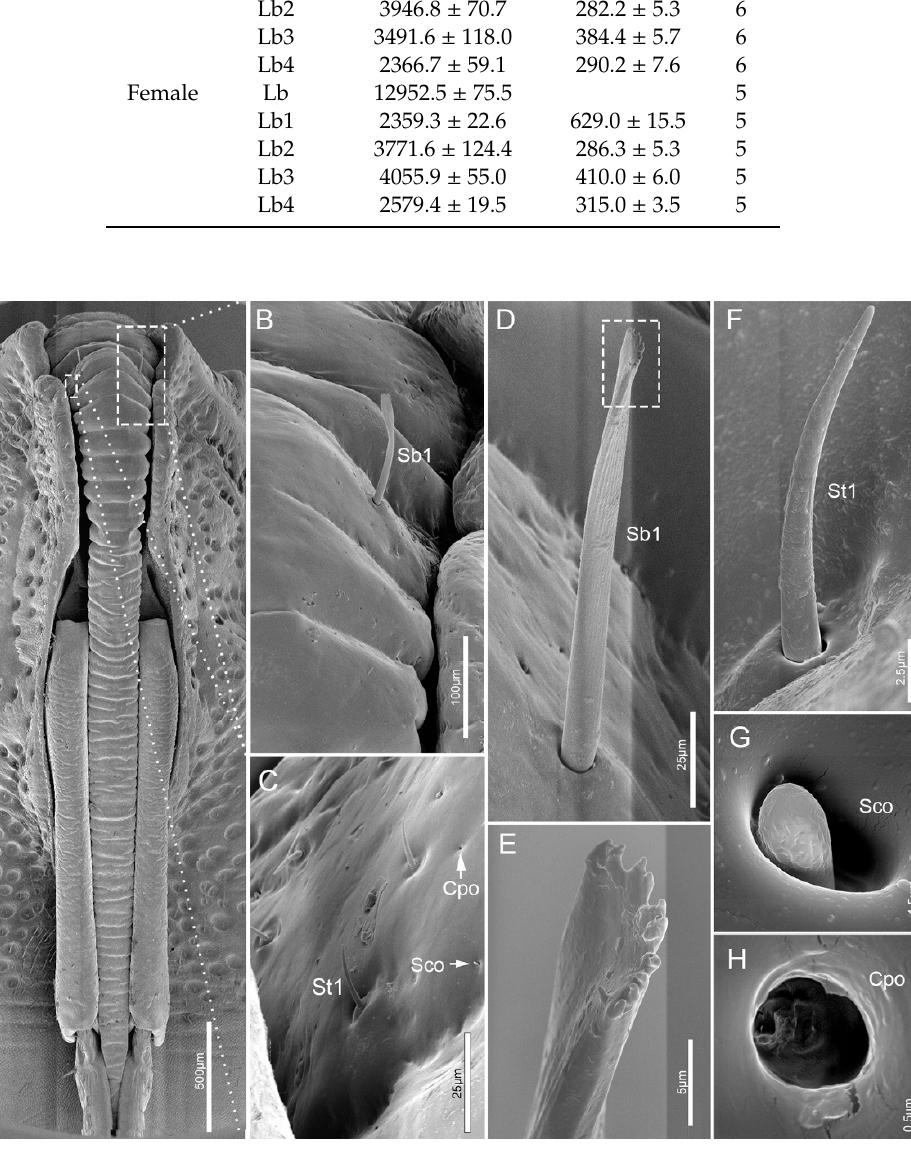
Figure 2. SEM of labrum of E. fullo . ( A ) Ventral view; ( B ) Enlarged view of box in ( A ), showing sensillum basiconicum 1 (Sb1); ( C ) Enlarged view of box in ( A ), showing sensilla trichodea 1 (St1), sensilla coeloconica (Sco) and cuticular pores (Cpo); ( D ) Sensillum basiconicum 1 (Sb1); ( E ) Enlarged view of box in ( D ); ( F ) Sensillum trichodeum 1 (St1); ( G ) Sensillum coeloconicum (Sco); ( H ) Enlarged view of cuticular pore (Cpo).